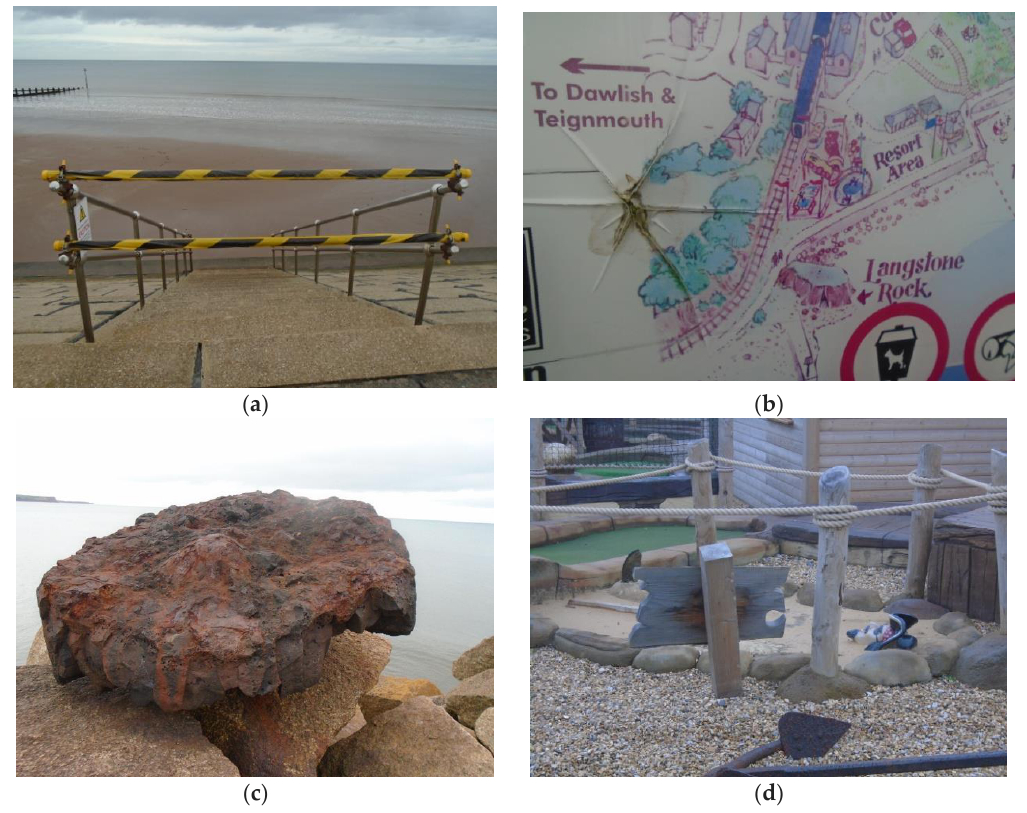
Figure 19. ( a ) Damaged steps; ( b ) Broken map; ( c ) Clinker; ( d ) Crazy golf course.